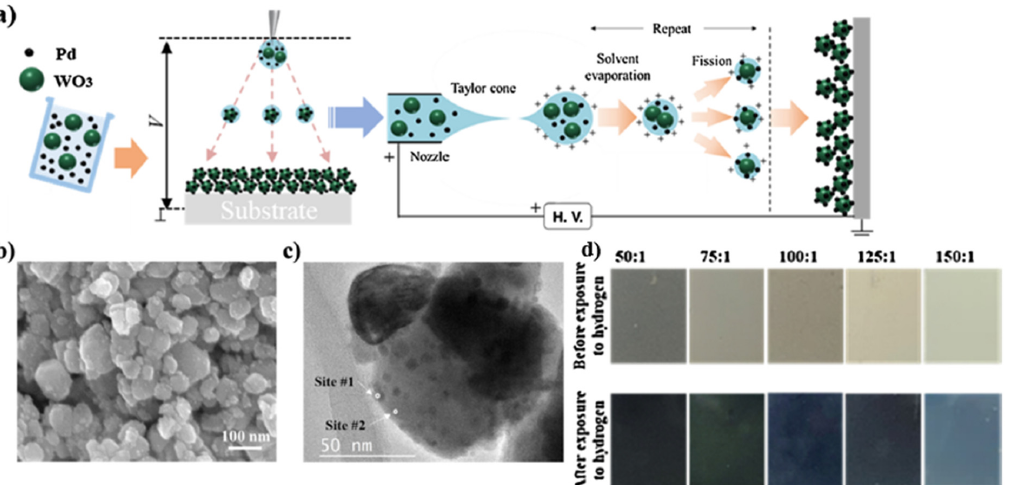
Figure 30. ( a ) Schematic of electrostatic spray deposition (ESD) process for fabricating WO 3 -Pd sensor, ( b ) SEM image of deposited WO 3 -Pd layer with a WO 3 :Pd ratio of 75:1, ( c ) TEM image of WO 3 -Pd, and ( d ) optical images of sensors with WO 3 :Pd ratios of 50:1, 75:1, 100:1, 125:1 and 150:1 before and after exposure to 1% hydrogen gas [131]. Copyright (2021), with permission from Elsevier.